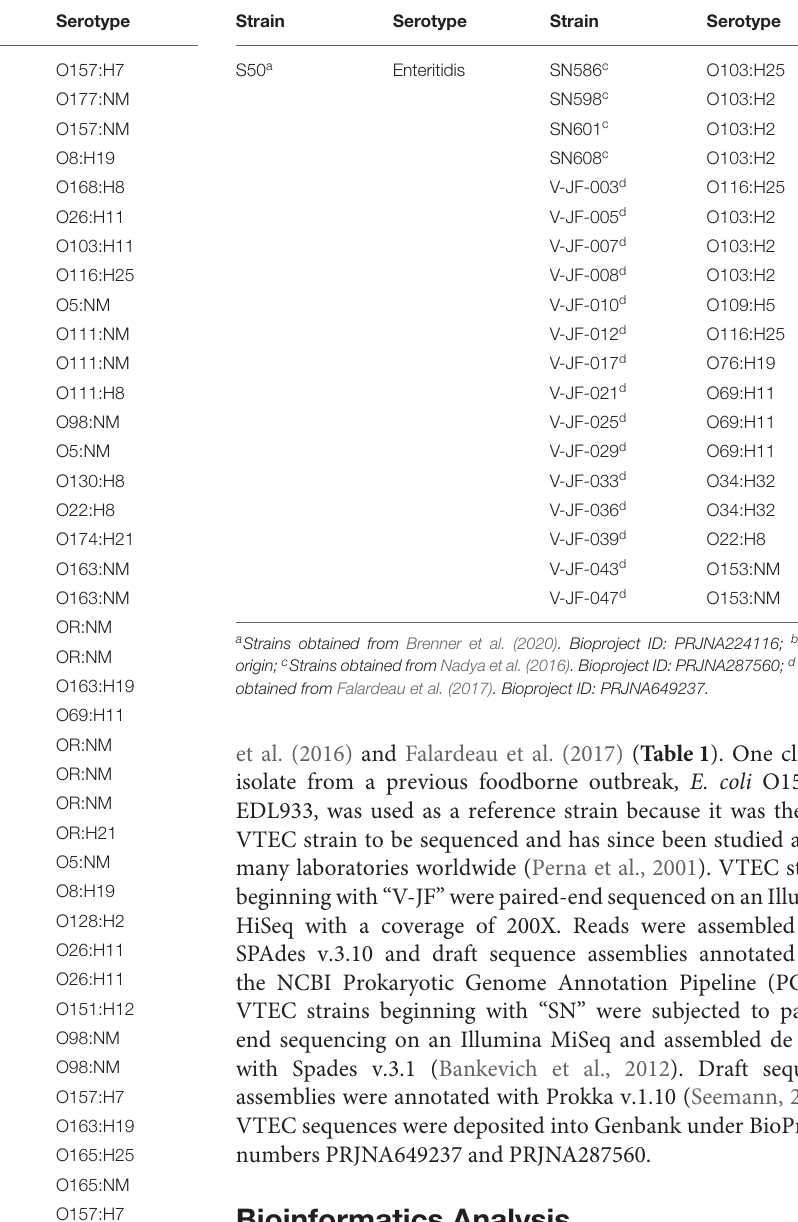
TABLE 1 | Salmonella and VTEC strains used in this study. Salmonella VTEC Strain Serotype Strain